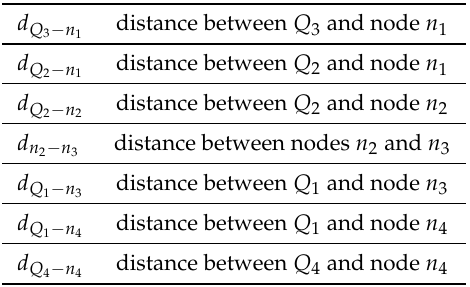
Table A1. Definitions of distances between